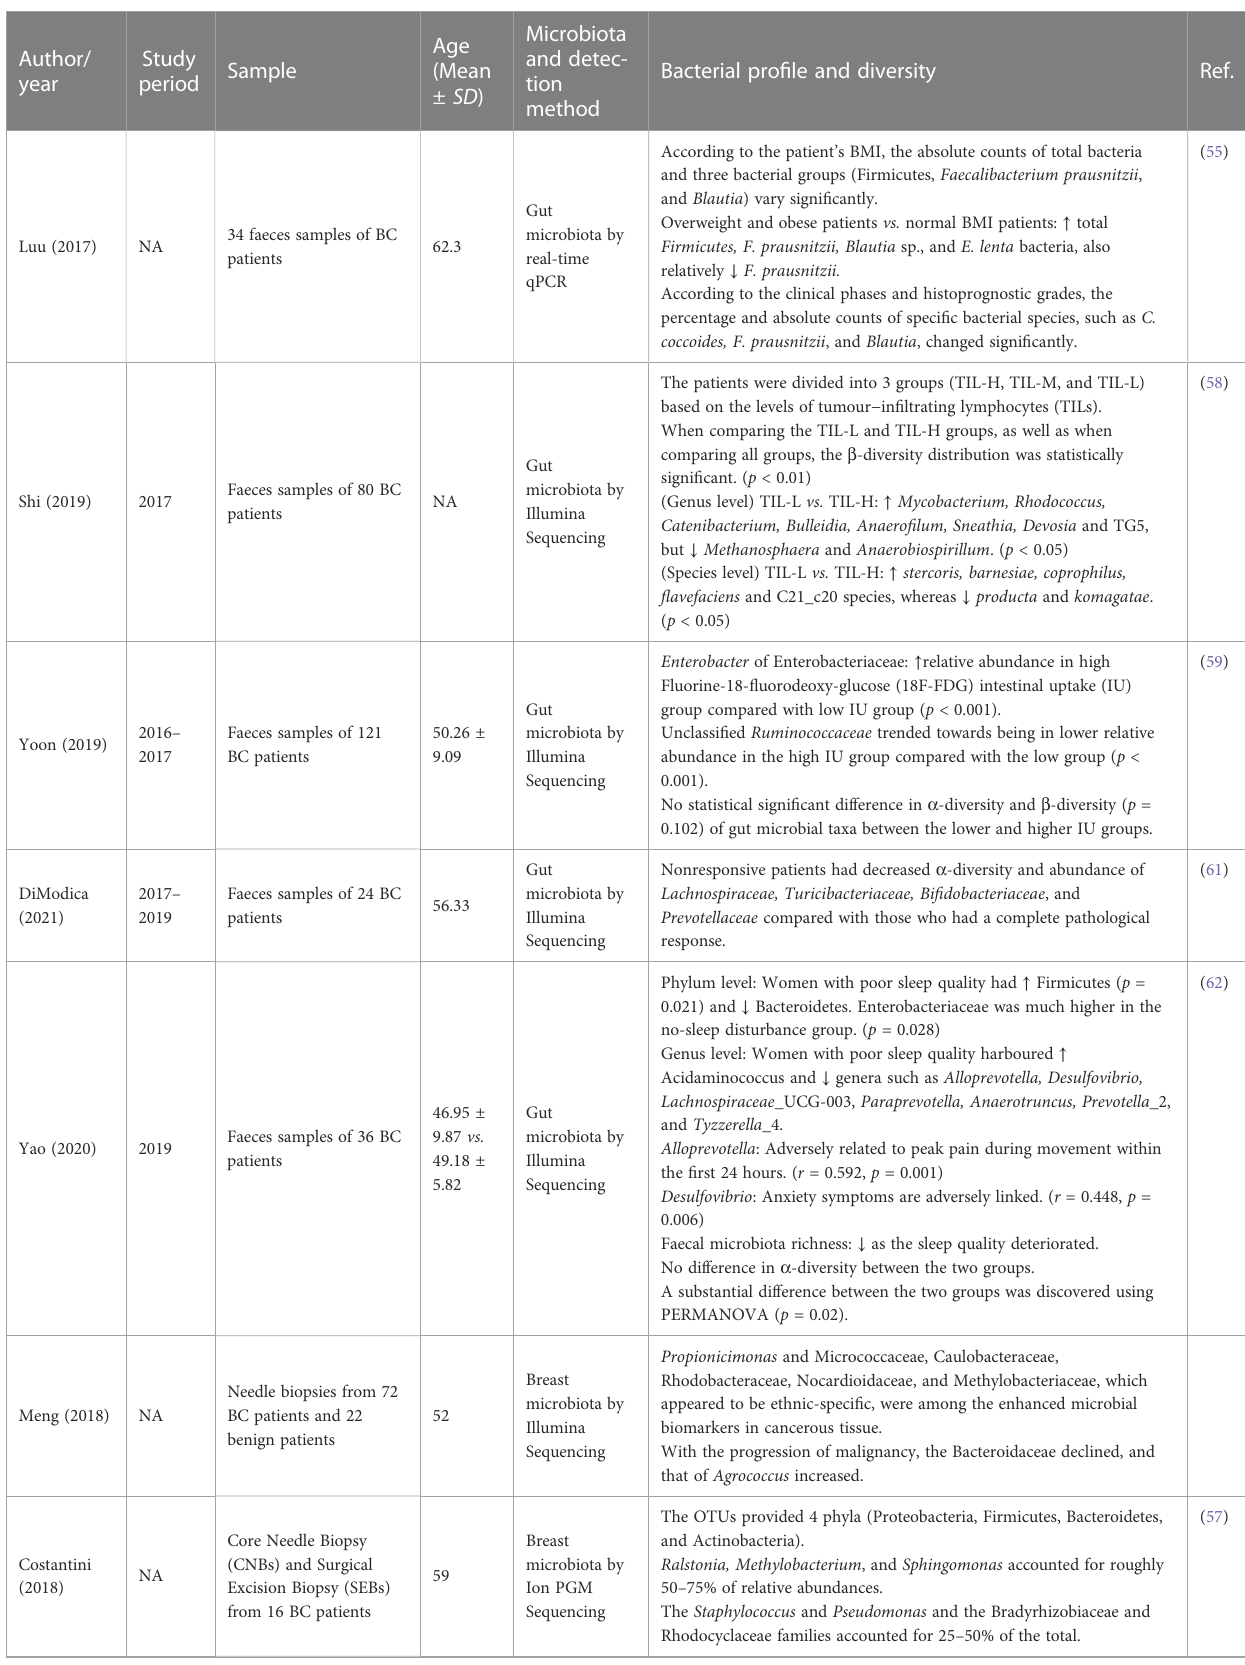
TABLE 3 Characteristics of cohort studies and their microbial pro fi ling and